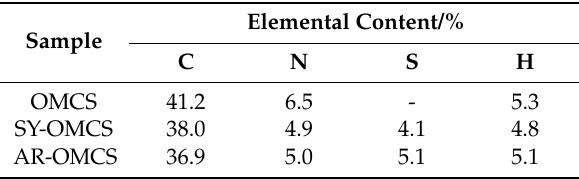
Table 1. Elemental analysis results of prepared polymer dyes.